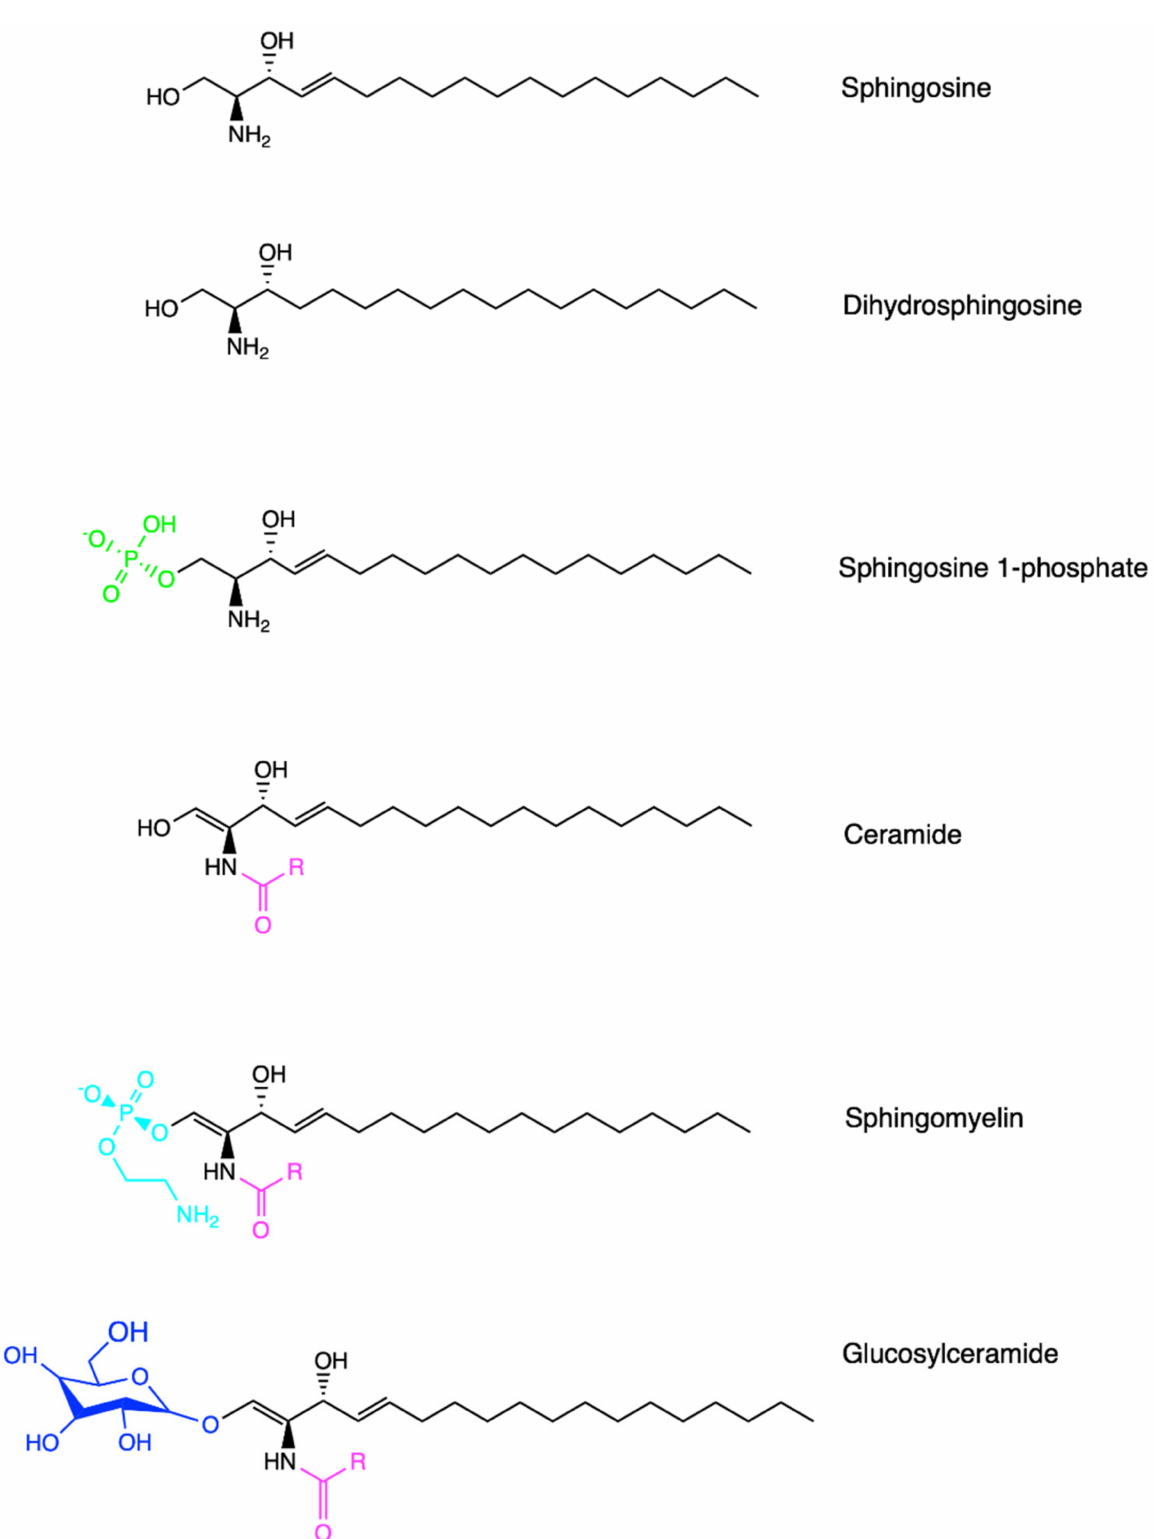
Figure 1. Chemical structures of sphingolipids. Sphingosine represents the common sphingolipid backbone as the sphingoid base. Dihydrosphingosine, also known as sphinganine, possesses a saturated sphingoid backbone. Ceramide contains an additional fatty acyl chain via the N-link to the sphingoid base. Sphingosine 1-phosphate, sphingomyelin and glucosylceramide are generated via O-linked modification from sphingosine or ceramide, respectively. Created in ChemDraw ®